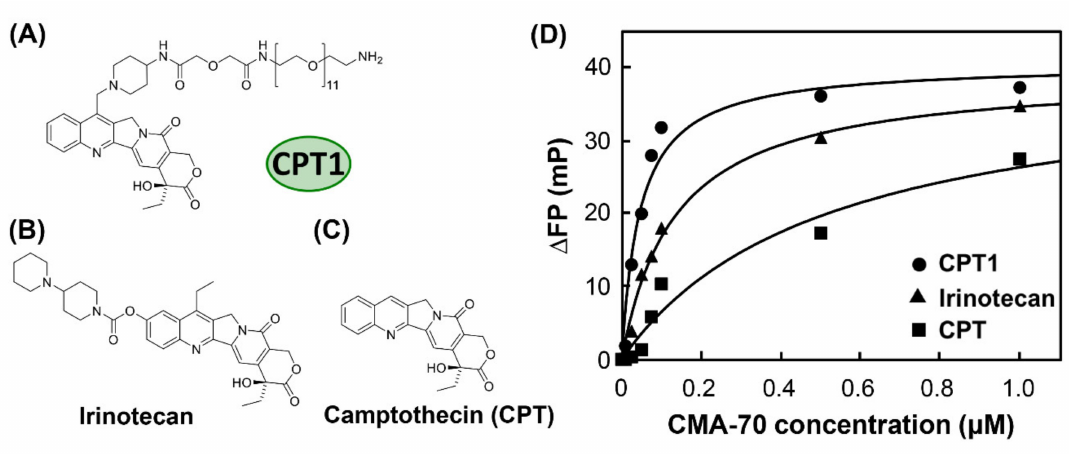
Figure 2. Chemical structures of ( A ) camptothecin derivative (CPT1), ( B ) irinotecan, and ( C ) camptothecin (CPT) and ( D ) titration curves for CPT1 ( • ), irinotecan ( (cid:78) ), and CPT ( (cid:4) ) polarization versus CMA-70 concentration; polarization was monitored at 456 nm using the excitation wavelength of CPT1, irinotecan, and CPT (372